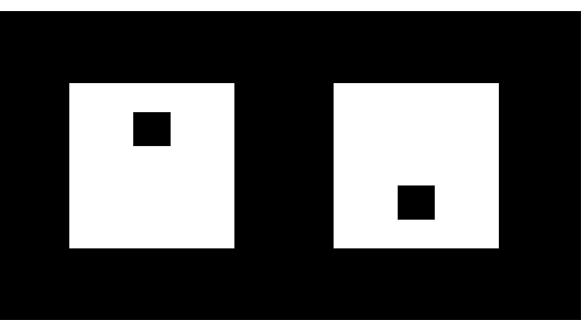
Fig. 1. Go (left) and NoGo (right) signals in the T.O.V.A. Reprinted with permission from the TOVA Company, Los Alamitos, CA